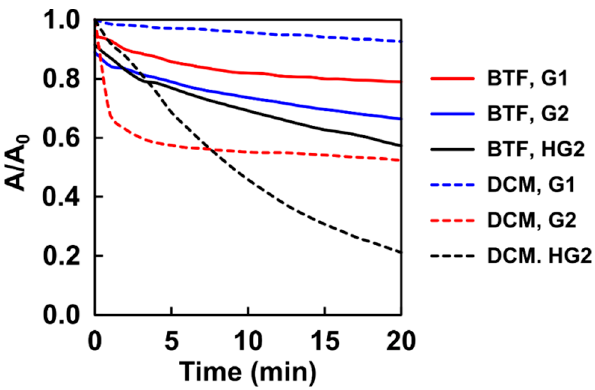
Figure 2. The consumption (A/A 0 ) of diethyl 2,2-diallylmalonate (c 0 = 35.6 mM) as a function of time in the ring-closing metathesis reaction in the presence of 1 mol% of ruthenium catalysts, G1, G2, and HG2 in benzotrifluoride and dichloromethane solvents at 25 °C (A: 1 H NMR signal integral of the vinylic hydrogen signal of diethyl 2,2-diallylmalonate; and A 0 : initial 1 H NMR signal integral of the vinylic hydrogen of diethyl 2,2-diallylmalonate; see Figure S4). Table 3. The solvent, the catalyst, rate constant, and the conversions after 20 min and 24 h in the ring-closing metathesis reactions of diethyl 2,2-diallylmalonate (c 0 = 35.6 mM) in benzotrifluoride (BTF) and dichloromethane (DCM) using 1 mol% G1, G2, or HG2 as catalysts. Solvent